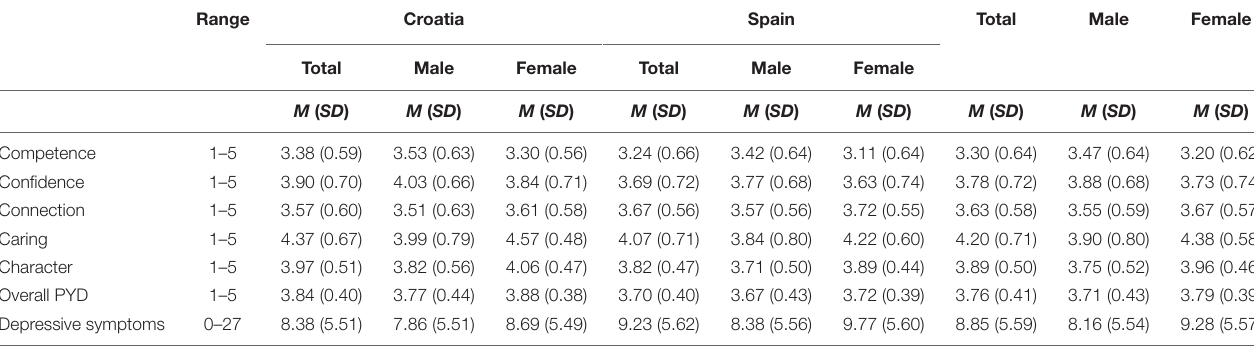
TABLE 1 | Descriptive statistics of depression and PYD, by country and gender.